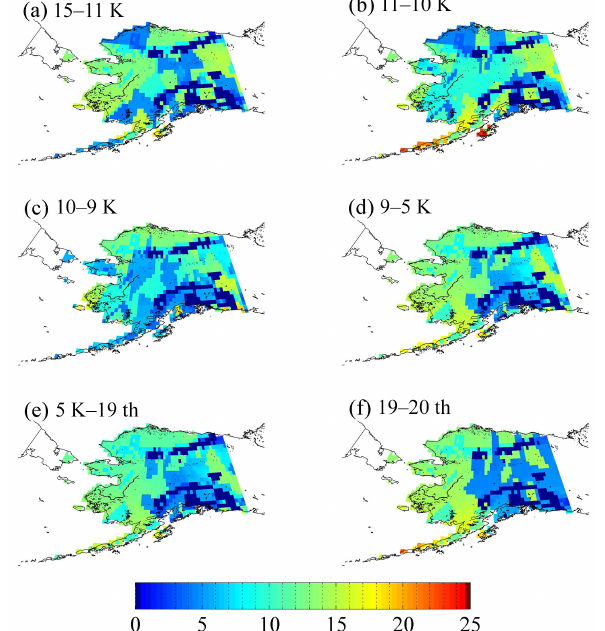
Figure 7. Average non-peatland (mineral) SOC density (kgCm − 2 ) during (a) 15–11ka, (b) 11–10ka, (c) 10–9ka, (d) 9–5ka, (e) 5ka– 1900AD, and (f) 1900–2000AD. The period of 9k–19th in Fig. 2d is separated into 9–5k and 5k–19th.